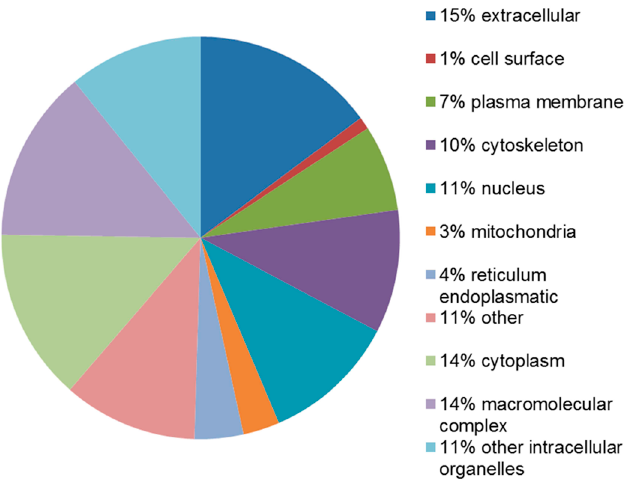
Figure 5. STRAP classification of proteins upregulated in the leiomyoma according to their subcellular localization.